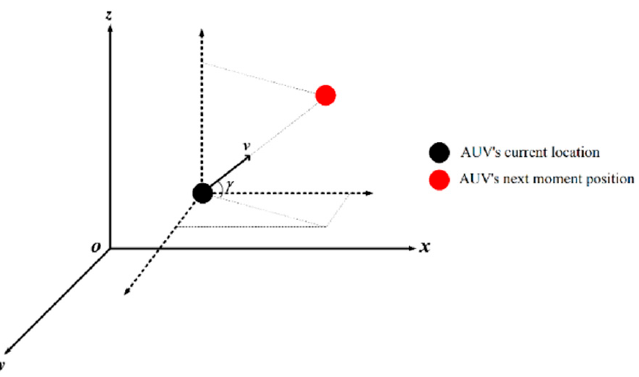
Figure 6. Schematic diagram of small angle navigation in vertical direction of AUV.